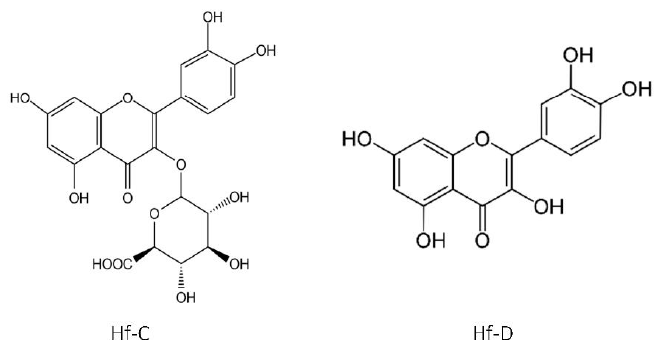
Figure 7. Compounds identified in H. foliosum DCM-MeOH extract; Hf-A chlorogenic acid; Hf-B catechin; Hf-C miquelianin; and Hf-D quercetin.